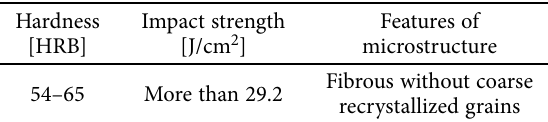
Table 1. Alloy 6082 used for production of connecting